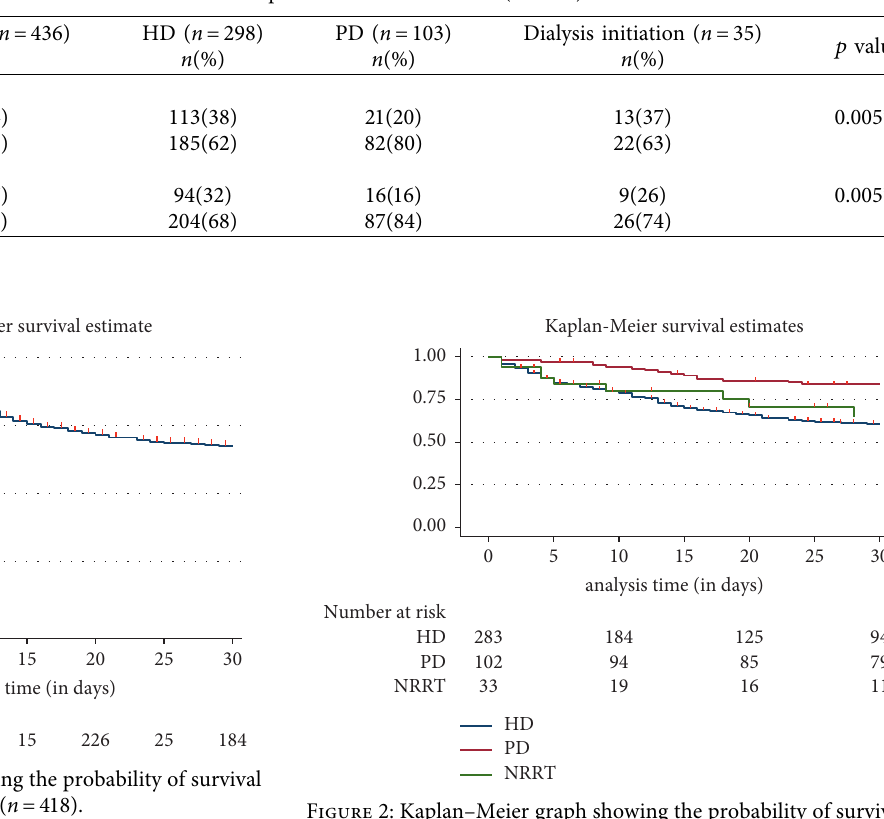
Table 4: Outcomes of CKD V patients with COVID-19 ( n � 436).